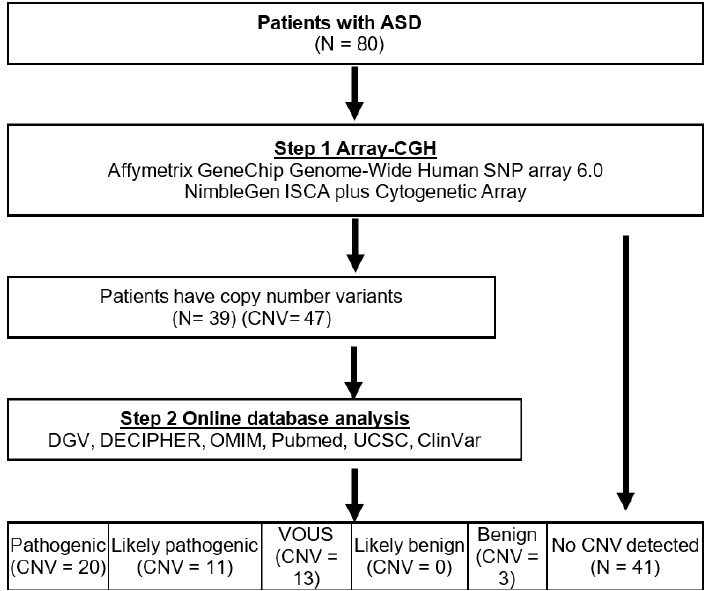
Figure 2. Diagnostic work-up of patients with autism spectrum disorder (ASD) ( N = 80). Abbreviations: ASD, autism spectrum disorder; CNV, copy number variant; VOUS, variance of uncertain significance.